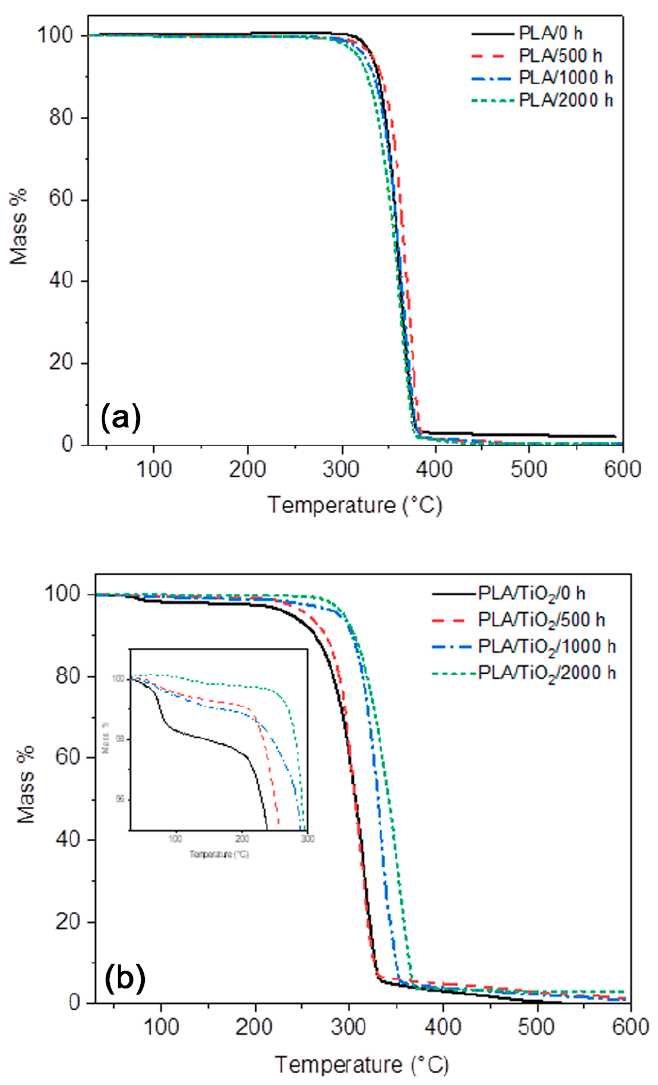
Figure 13. TGA curves for the ( a ) PLA and ( b ) PLA/TiO 2 samples after different periods of accelerated weathering.